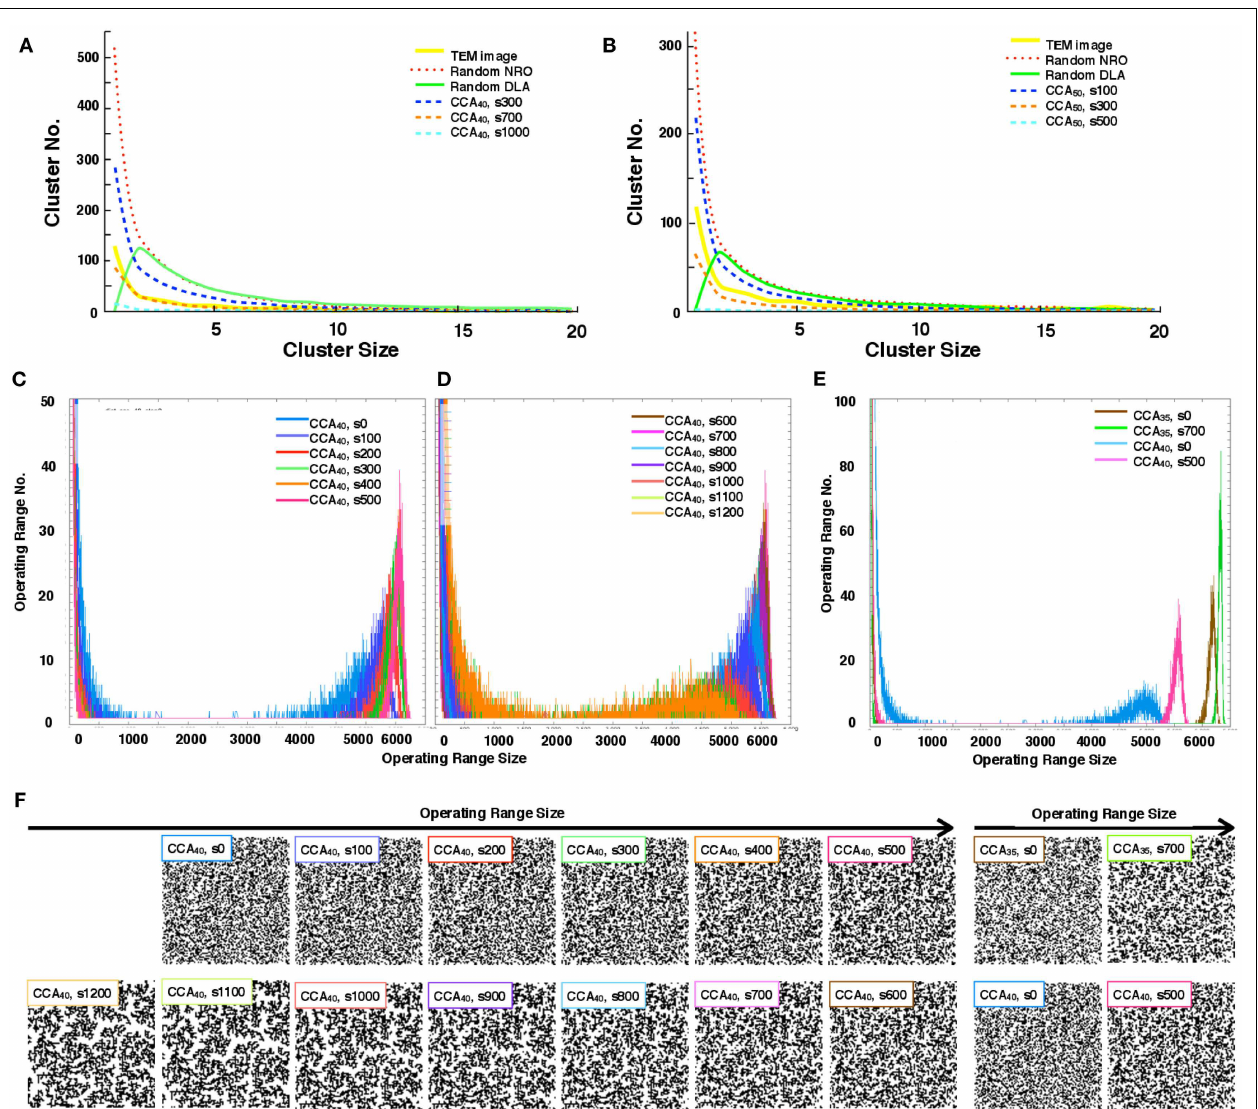
step, purple; 1,000th step, deep orange; 1,100th step, light green; 1,200th step, light orange). (E) Size distribution of operating range in the CCA model with 35 or 40% NRO (CCA with 35% NRO at the 0th step, brown; CCA with 35% NRO at the 700th step, green; CCA with 40% NRO at the 0th step, light blue; CCA with 40% NRO at the 500th step). (F) Reaction space appearance at each condition. Images of corresponding simulated reaction spaces to the lines in panels (C,D,E) are captured and shown according to the peak value of the size of the distribution of their operating range. Each simulation condition is shown at the top-left position of each image. Six images arranged at the upper left space portray the appearance of reaction spaces used for the graph in (C) . Seven images arranged at the lower left space are the appearance of reaction spaces used for the graph in (D) . Four images in the right space are the appearance of reaction space used for the graph in (E)